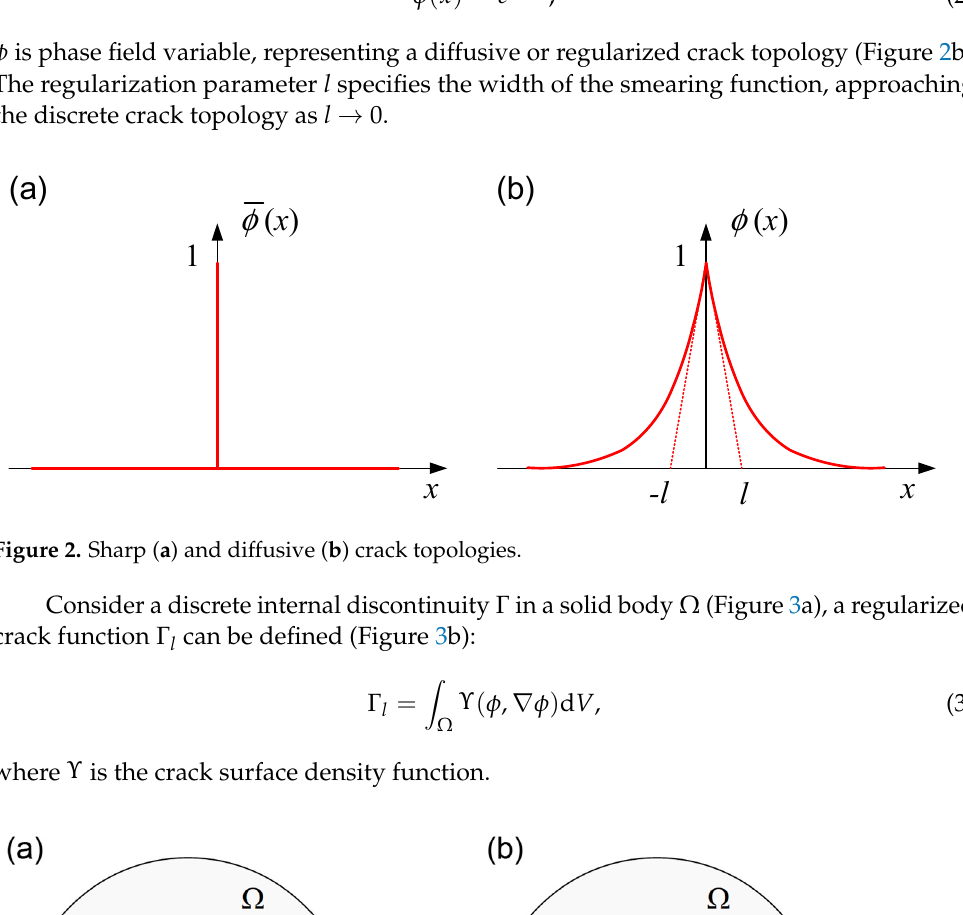
Figure 3. Schematic representation of a solid body. ( a ) Internal discontinuity boundaries, and ( b ) a phase fi eld approximation of the discrete discontinuities.